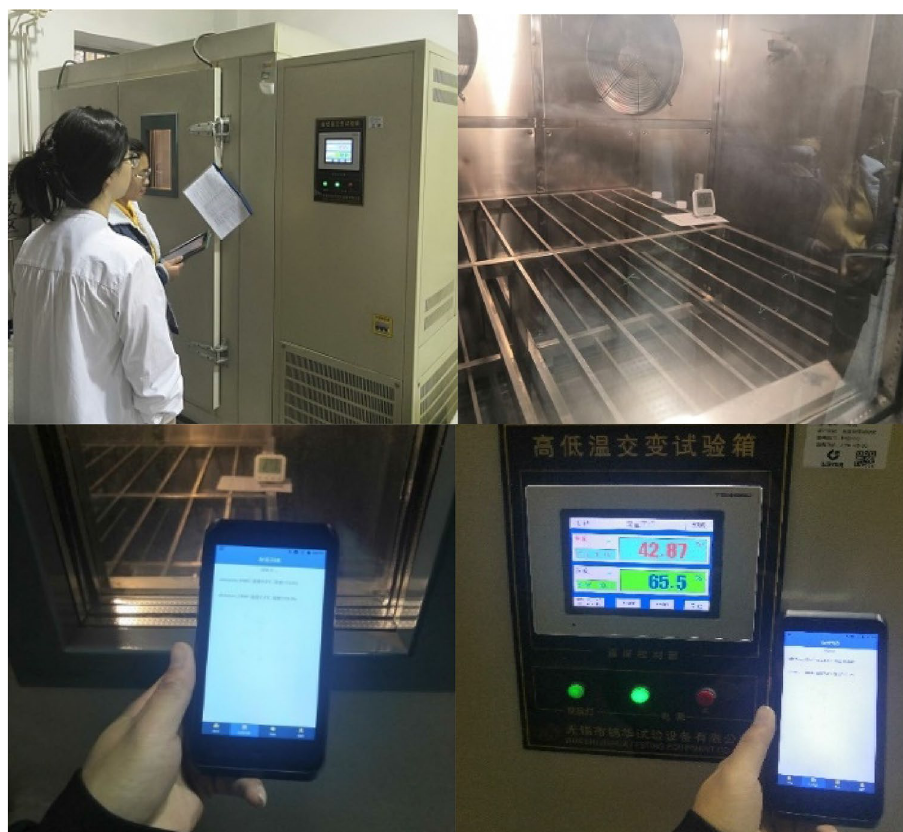
Figure 18. Test of temperature and humidity monitoring.